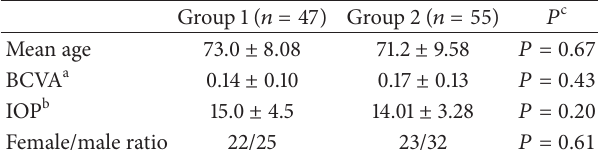
Table 1: Demographic and clinical properties of the groups.